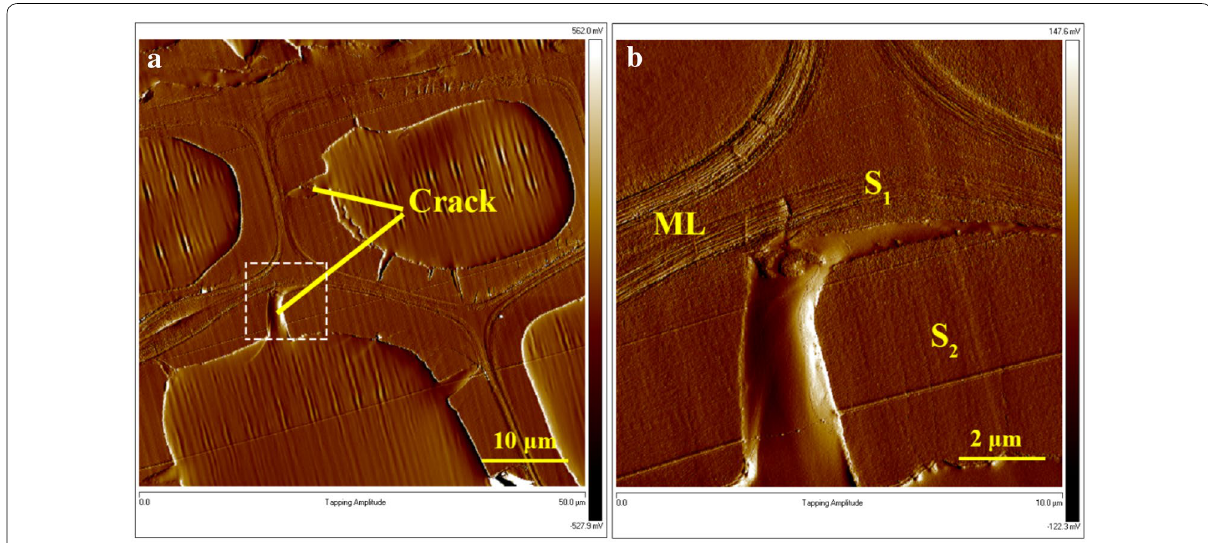
Fig. 6 a Fracture and initial crack location of the cell wall subject to longitudinal tensile stress; b partial enlarged detail of